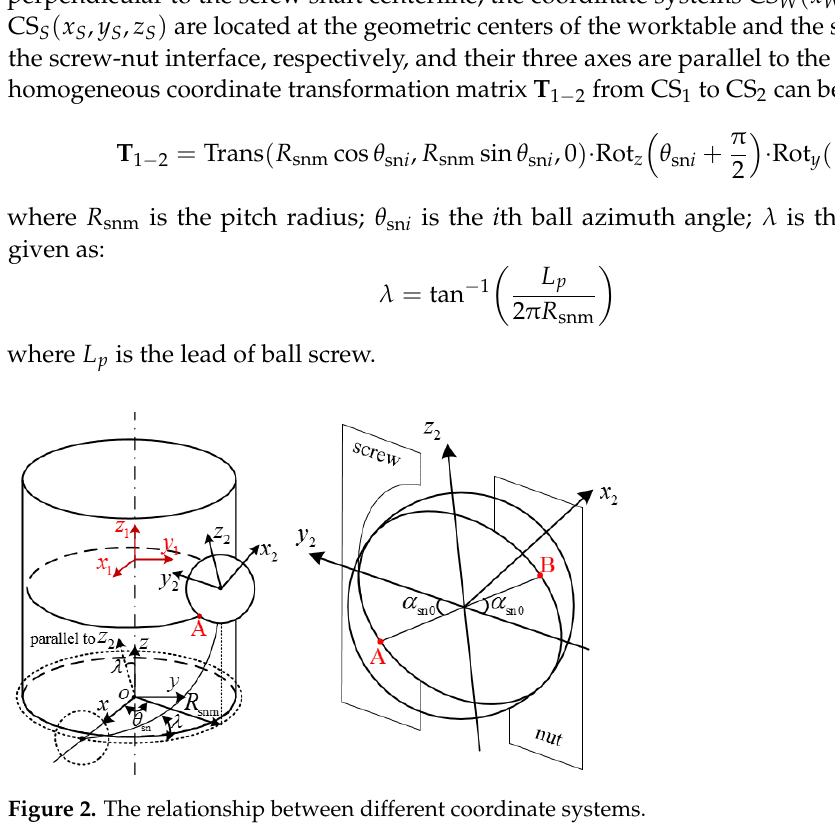
Figure 1. Structure of ball screw feed system.